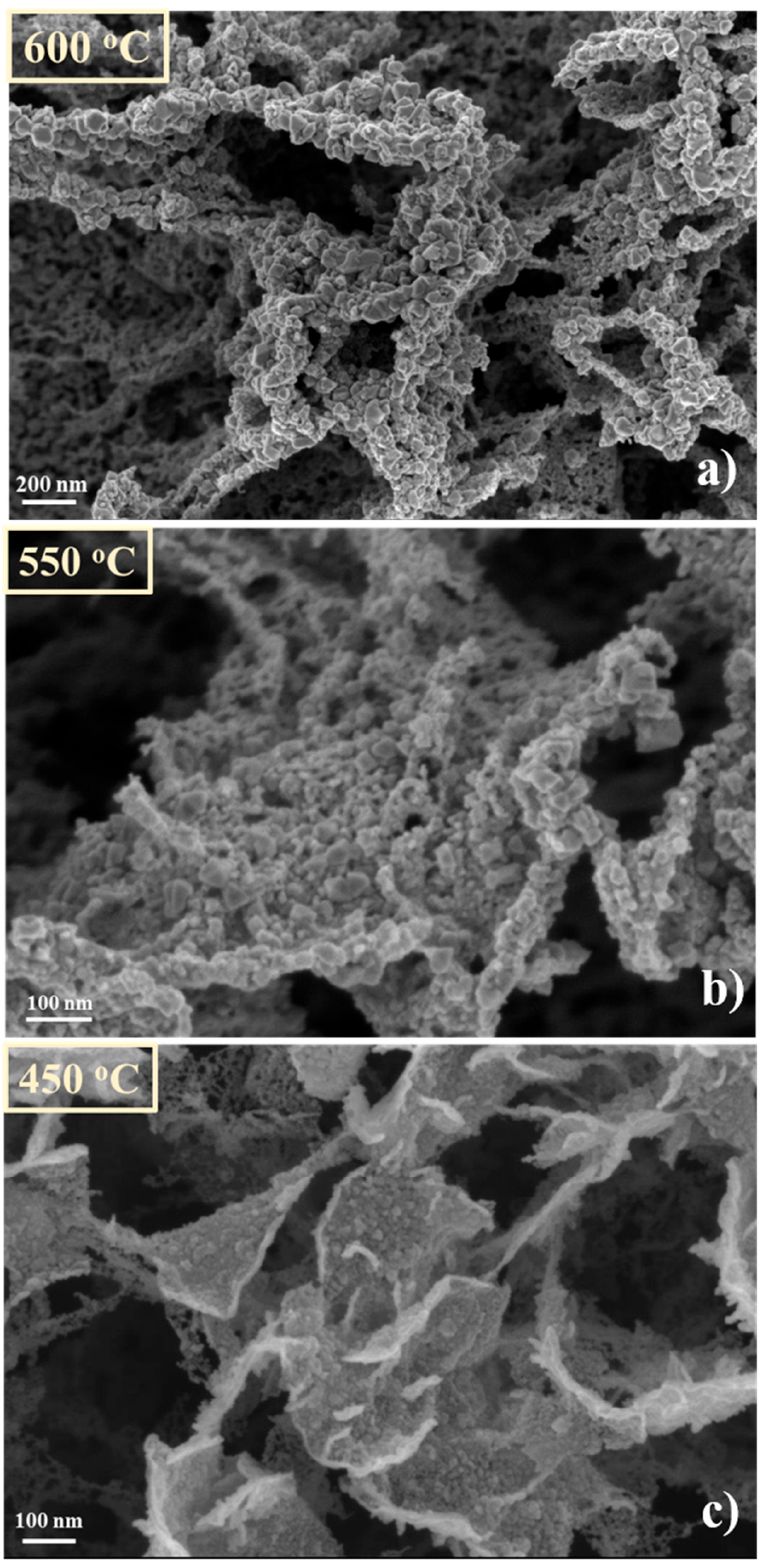
Figure 14. SEM images of CNW surfaces after decoration process performed in presence of plasma ( plasma on ), at different temperatures ( a )—the first position corresponding at 600 °C, ( b )—the second position corresponding at 550 °C, ( c )—the third positions corresponding at 450 °C).